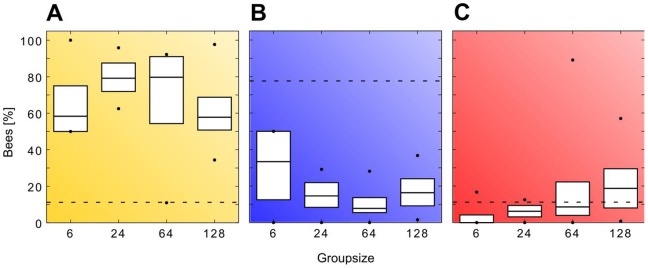
Results of the experiments with complex gradients.Shown is the percentage of bees (median, quartiles, minimum and maximum) a) in the left zone (36±1°C), b) outside the zones (31±1°C) and c) in the right zone (32±1°C) at the different group sizes (N = 8/group size). The dashed line represents the percentage of bees predicted by the UDM.